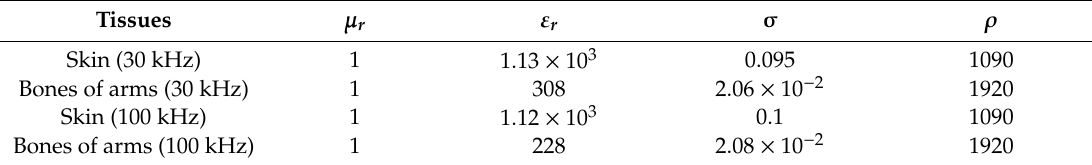
Table 2. Dielectric properties of the skin and bones of the hand at 30 kHz and 100 kHz.